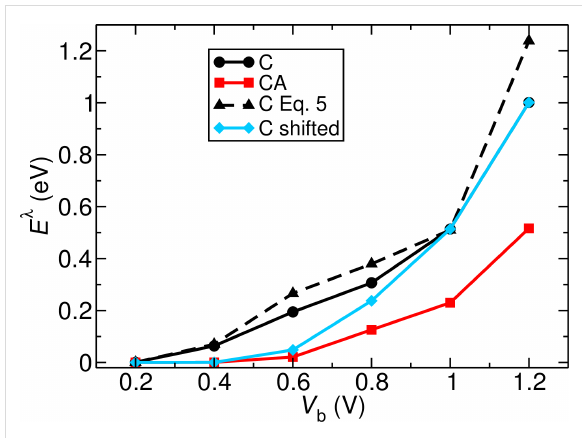
Figure 5: Energy stored in the mode at = 176 meV as a function of applied bias for the C and CA junctions, and for a C junction with spectral functions shifted so as to match the LUMO of the CA struc- ture. The black, dashed line represents the stored energy for structure C calculated using Equation